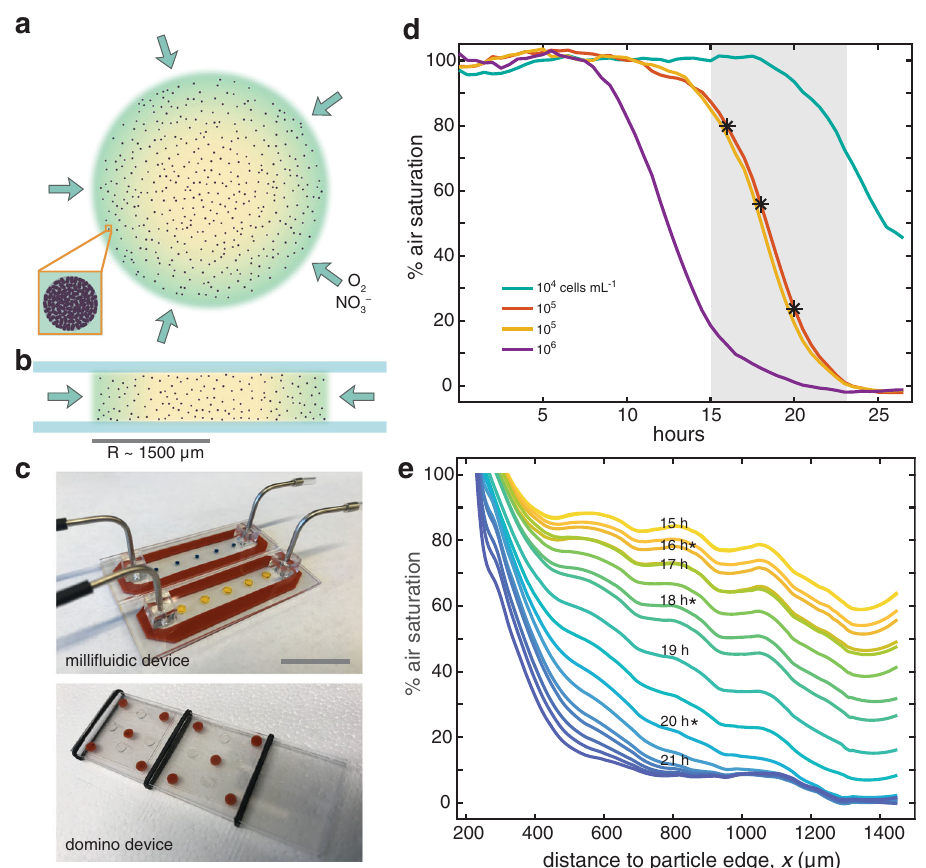
Fig. 1 Denitri fi ers create anoxia within particles in fully aerated fl uid. Agarose disc particles seeded with P. aeruginosa PAO1 were incubated with media in glass devices that permit only lateral diffusion into particles. a Topview and b sideview illustrating nutrient diffusion into particles as occurred in c , a milli fl uidic device with directional fl ow of air-saturated fl uid, or a ‘ domino ’ device held within sealed glass bottles. Scale bar ~1.5 cm. a inset, PAO1 cells grew as dense microcolonies. d Air saturation across four particles as determined from microscopic signal of fl uorescent oxygen nanosensors. Despite aerobic bulk fl uid surrounding the particles, cell growth created anoxia and its onset depended on PAO1 seeding density, ranging 10 4 – 10 6 cells mL − 1 (70 – 7000 cells particle − 1 ; the 10 5 mL − 1 cell density was tested for duplicate particles). Gray shading indicates time range shown in e and asterisks coincide with noted timepoints in e . e The air saturation for radial pro fi les across a single particle (10 5 cells mL − 1 seeding) during the cellular respiration-driven transition from air-saturated to anoxic conditions. Suboxia fi rst developed in the core ( x > 1000 μ m) then spread to the particle periphery ( x < 600 μ m). The 200 μ m region closest to the particle edge was not resolved in this